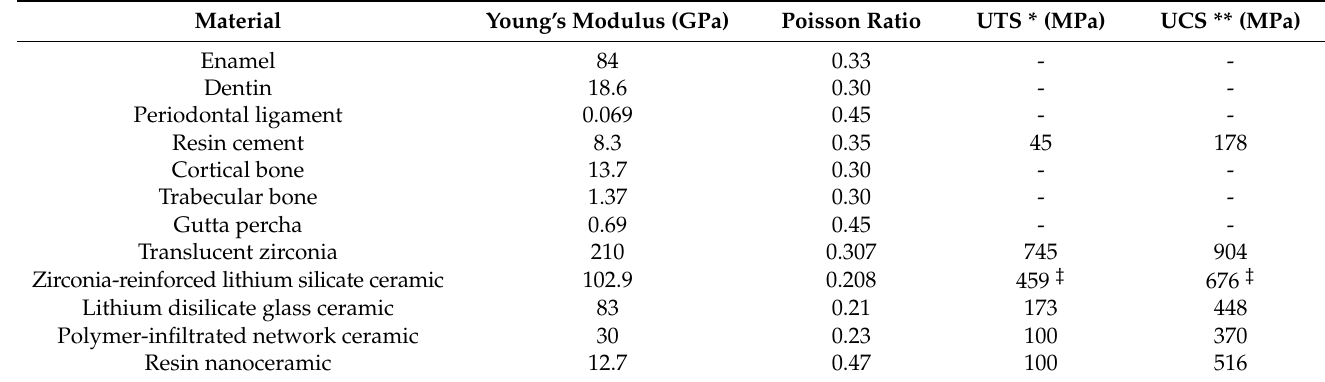
Table 3. The mechanical properties of the